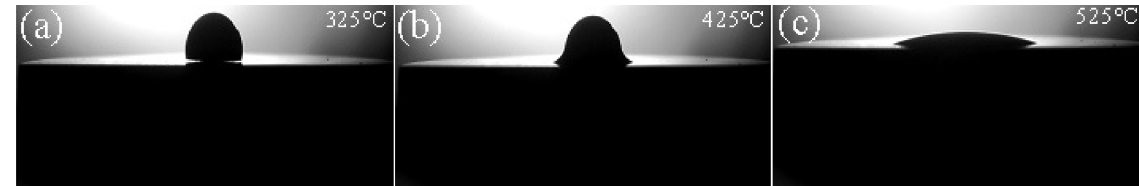
Fig. 6 Wettability measurements wherein contact angle was analyzed using ImageJ software: (a) carbonate pellet on the 50CP–50PSFC substrate, (b) incipient melting of carbonate pellet, and (c) spread carbonate drop.